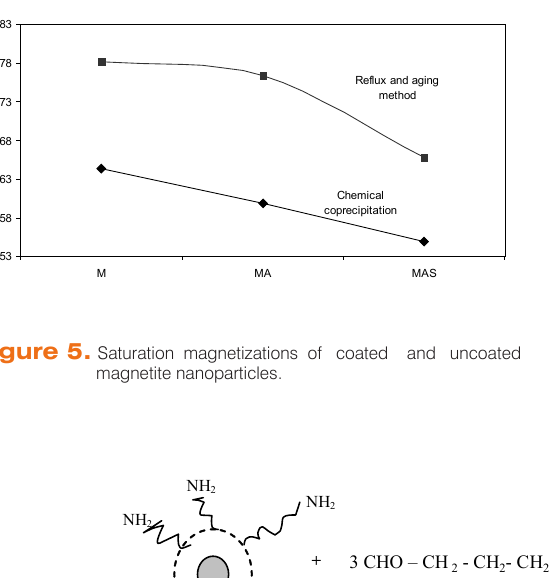
Figure 4. Hysteresis loop of magnetite obtained by chemical + coprecipitation and reflux and aging method .